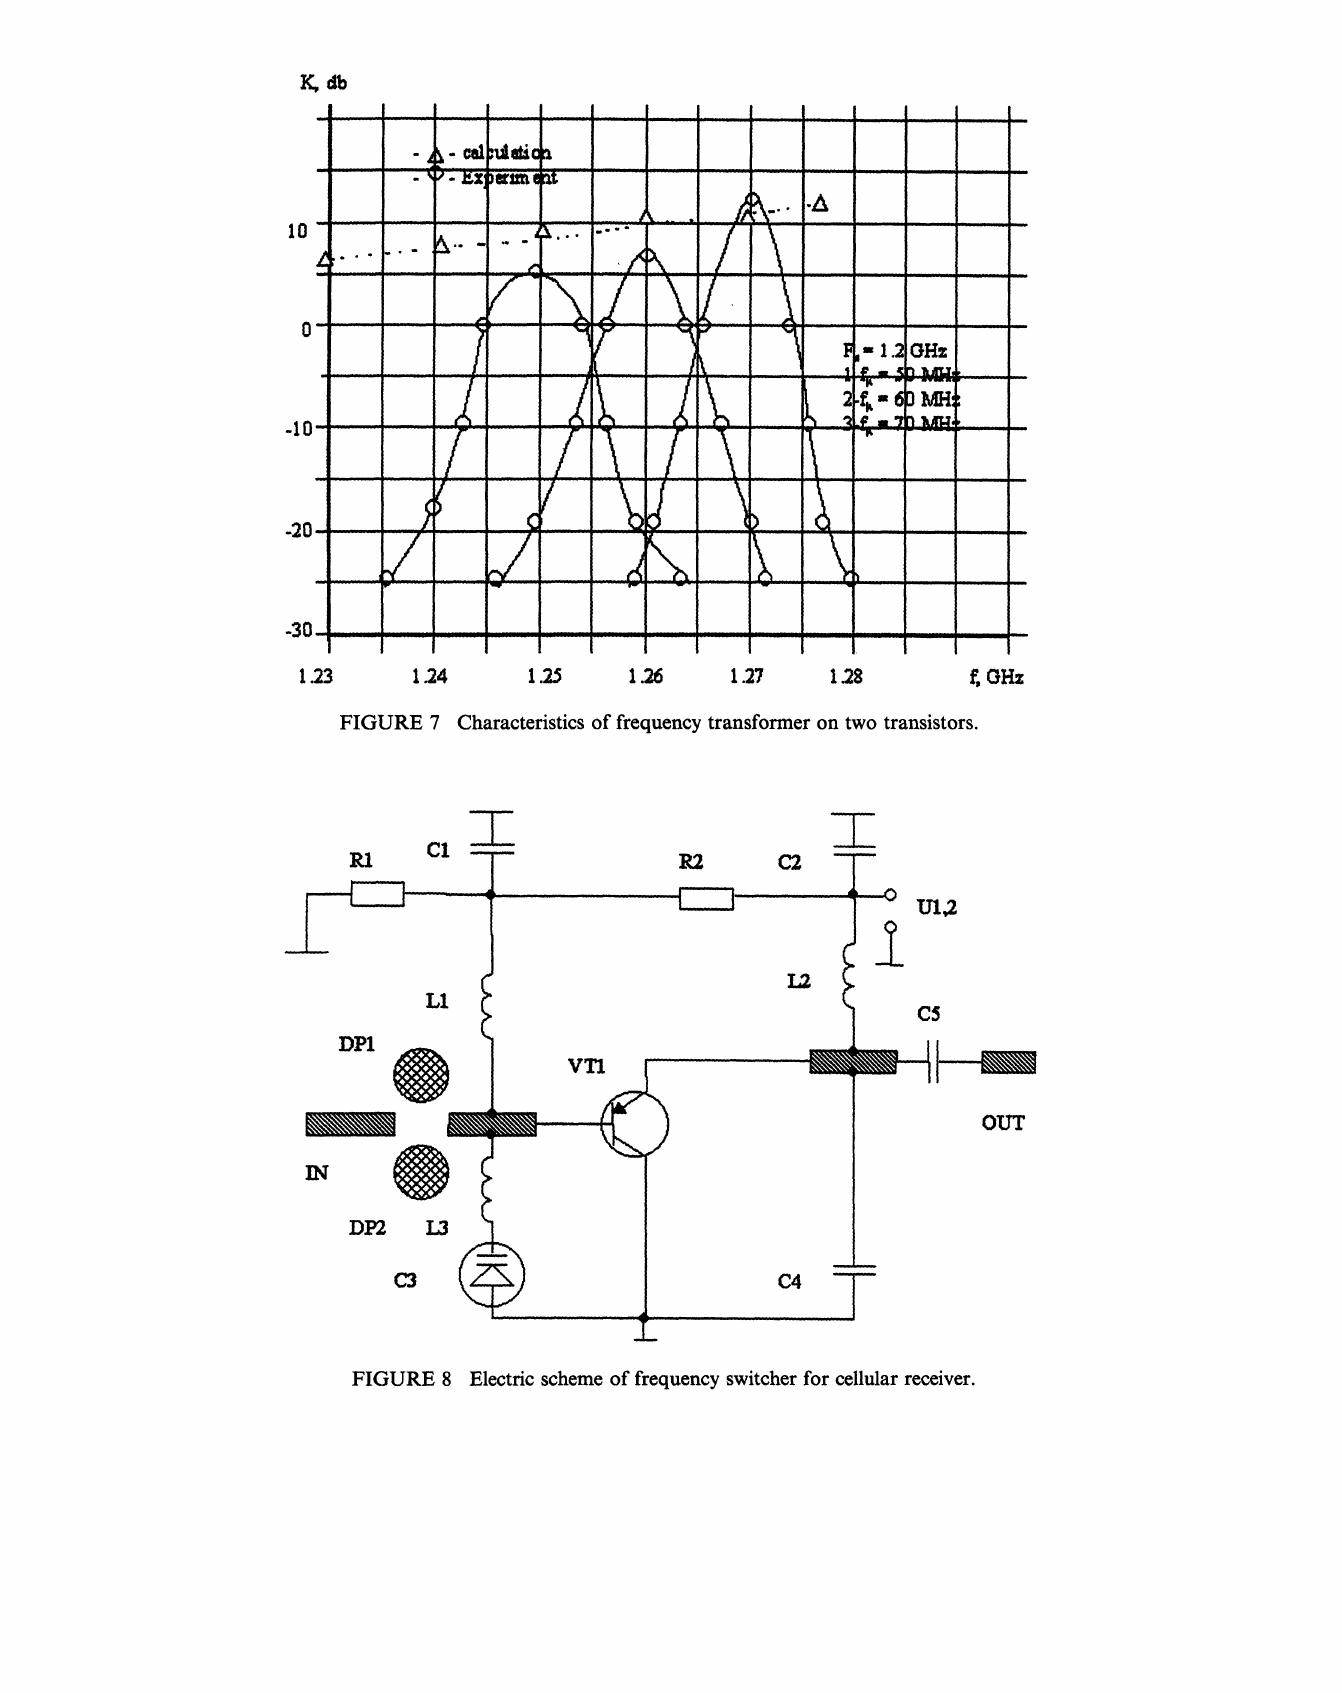
FIGURE 7 Characteristics of frequency transformer on two transistors.